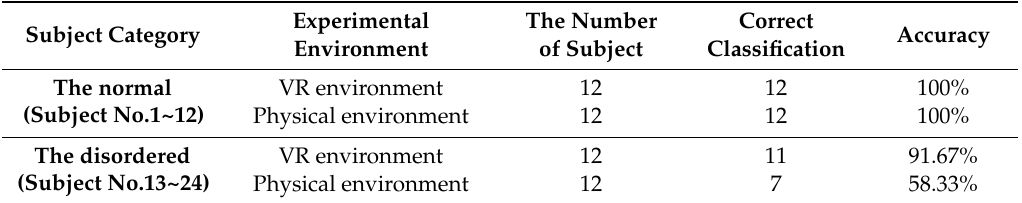
Table 2. Comparison of classification accuracy under a VR environment and a physical